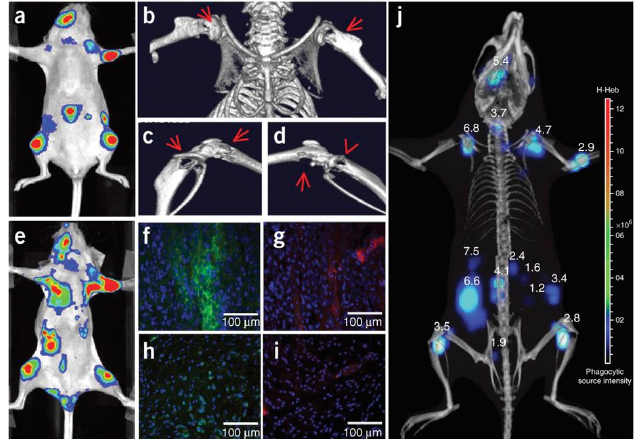
Figure 14. BLI, CRET and micro-computed tomography of the presence of MPO activity in MDA-MB-231-luc2 tumor metastases. ( a ) BLI of the tumor metastases 3 weeks after intracardiac injection of tumor cells. ( b – d ) Micro-CT imaging showing osteolytic lesions indicated by the red arrows at the metastasis tumor sites. ( e ) MPO activity in these lesions analyzed with Luminol-R. ( f – i ) Immunohistological analysis. ( f , g ) Tumor sites and ( g , i ) healthy tissues from a control mouse from a similar location as the metastases. ( f , h ) correspond to the staining of neutrophils and ( g , i ) to the staining of MPO. ( j ) Recording of 3-D CLI and micro-CT imaging showing the metastatic lesions in an anatomical configuration. Tumor depths measured with the reconstruction algorithm DLIT. Reprinted with permission from [159]. Copyright 2013, Springer Nature.